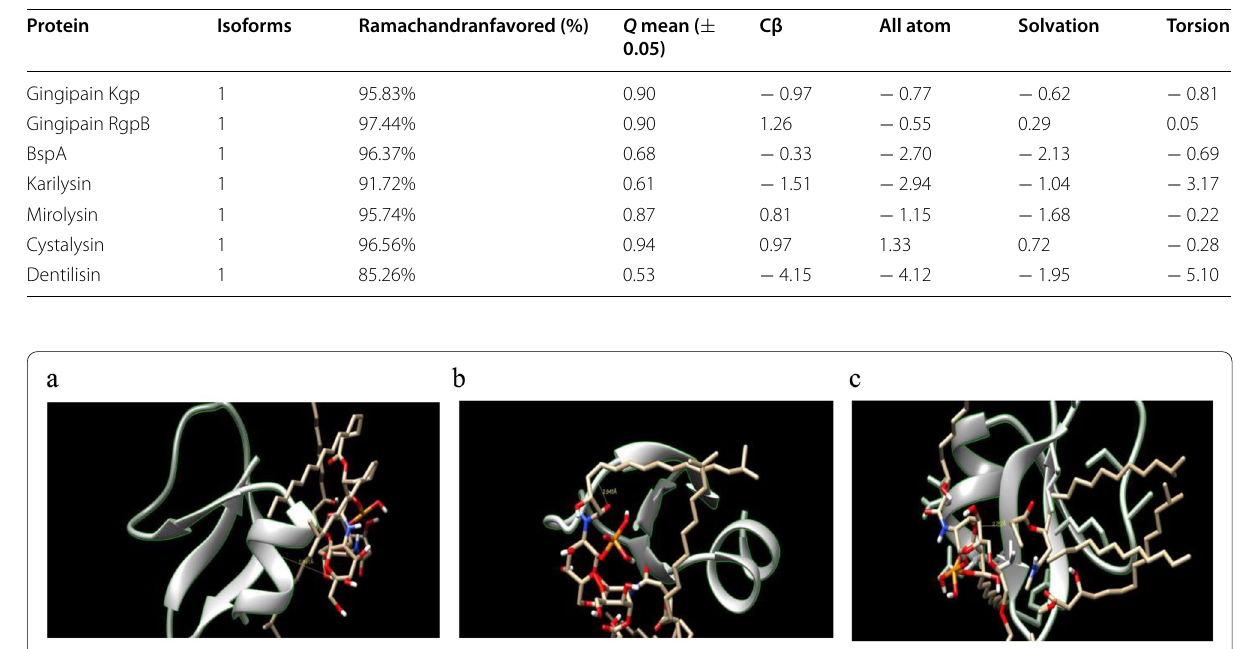
Table 5 Model evaluation and scoring